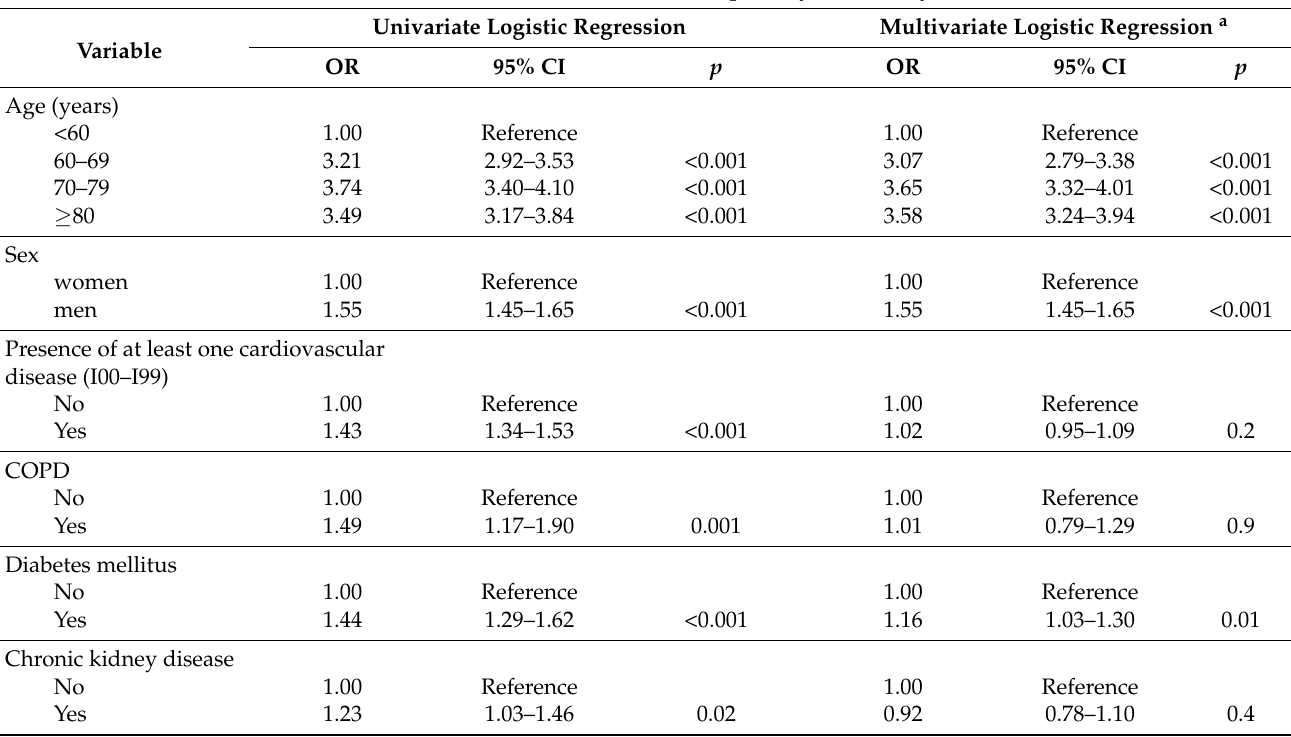
Table 3. Odds ratios (OR) and 95% confidence intervals (CI) for the acute respiratory distress syndrome (ARDS) in a group of 116,539 patients hospitalized with COVID-19—Poland,